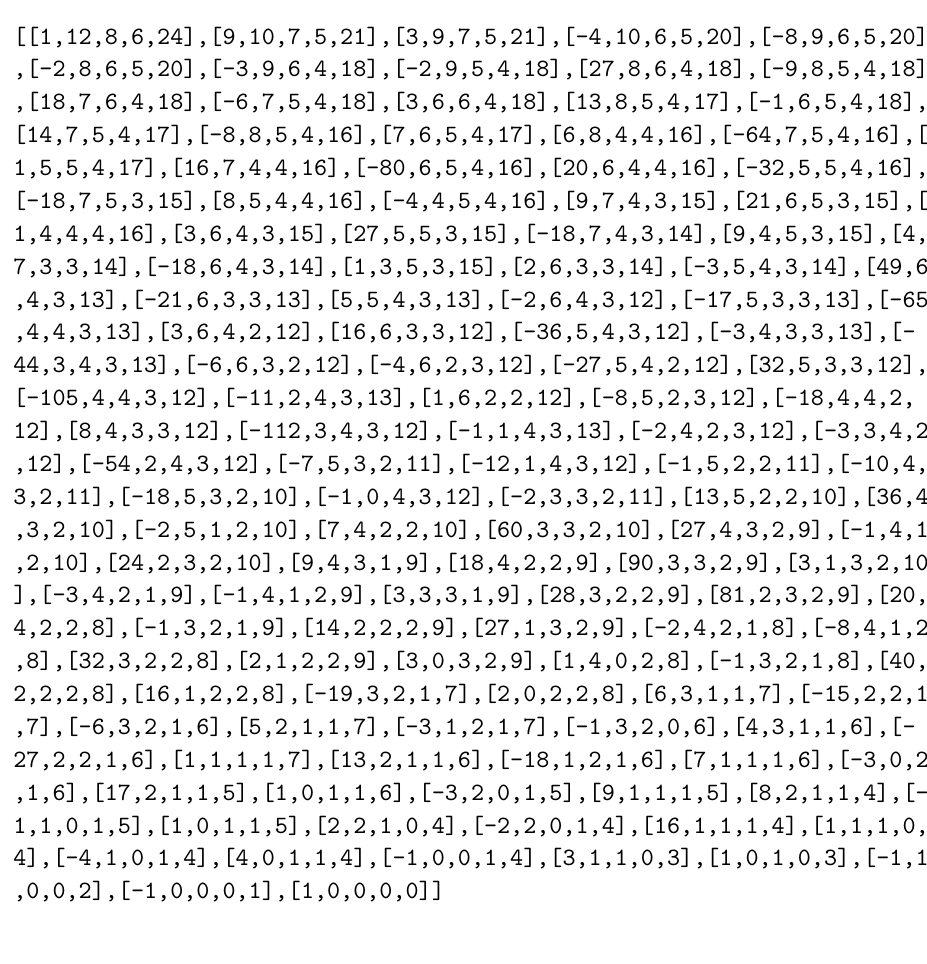
Figure 26 . Newton polygon and the initial form init r 0 (red nodes) for diag(3 ; 4 ; 4) quiver. diag(2 ; 3 ;